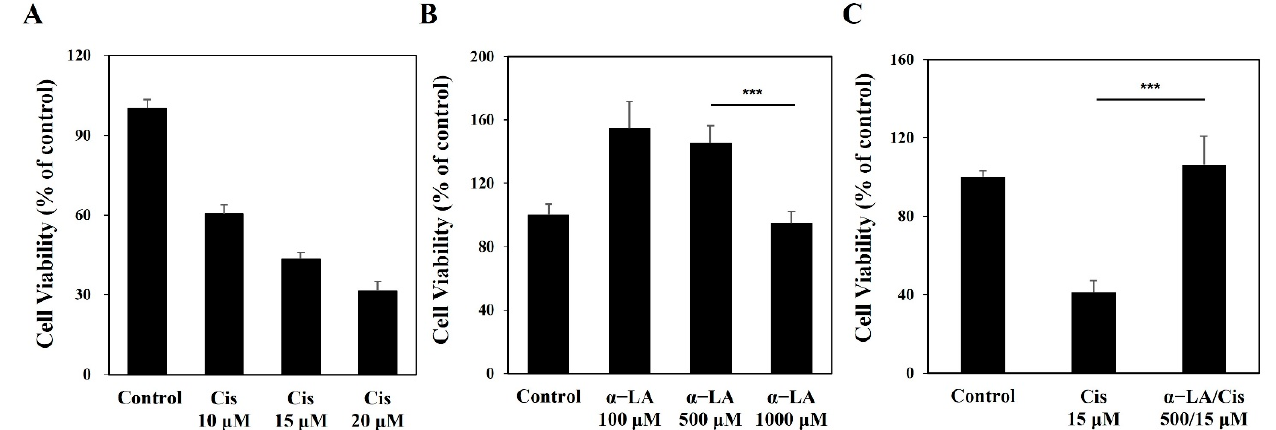
Figure 1. Viability of HEI-OC1 cells treated with cisplatin and α -LA. ( A ) Cisplatin-induced cytotoxicity increased in a dose-dependent manner. ( B ) The toxicity test of α -LA toward HEI-OC1 cells showed a significant decrease at the concentration of 1000 μ M. ( C ) α -LA showed protective effects against cisplatin-induced damage in HEI-OC1 cells. (*** p < 0.001, determined using an independent t test). The group treated with cisplatin alone is abbreviated as Cis, while the group with α -LA pretreatment is abbreviated as α -LA/Cis.